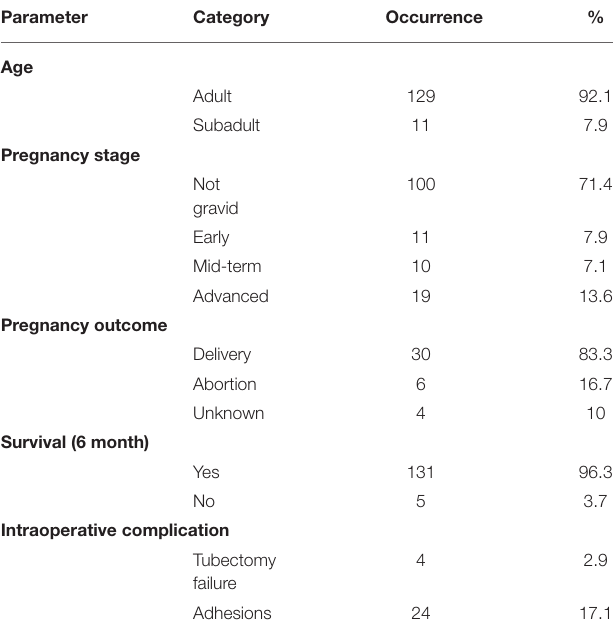
TABLE 1 | Data summary of the treated females ( N = 140) with frequency and proportion (%) of age class (adult, subadult), pregnancy stage at the time of the intervention, pregnancy outcome, female survival at least 6 months following surgery, and intraoperative